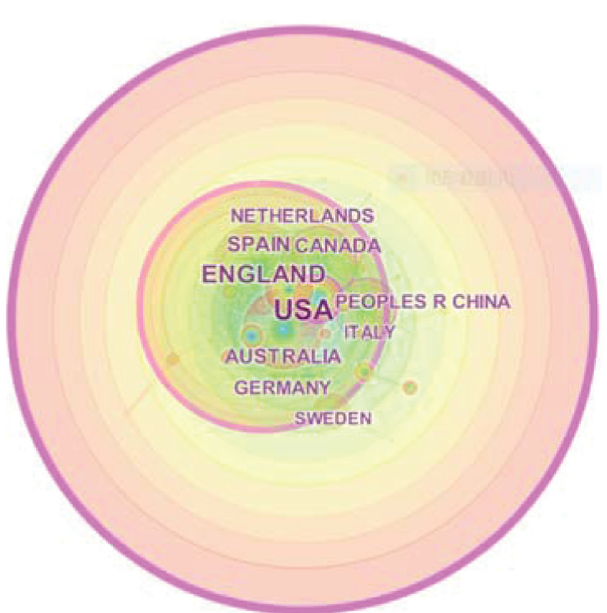
Figure 7. The time zones of